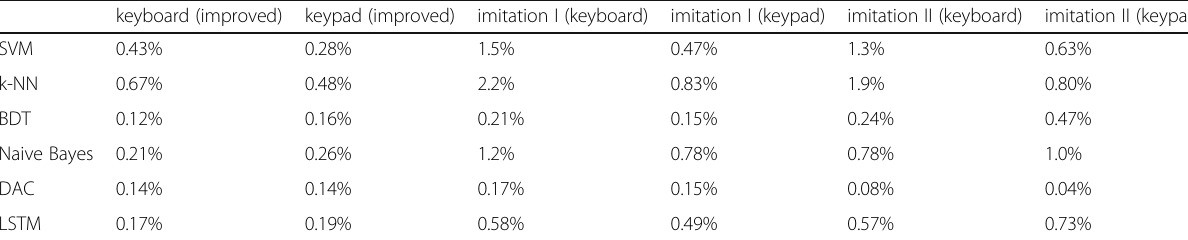
Table 3 FAR in different scenarios